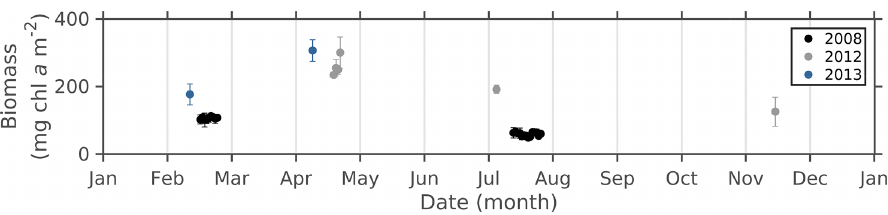
Figure 5. Daily averaged in situ MPB biomass (mgChl a m − 2 ) sampled in the sediment first centimetre at the study station on the Brouage mudflat in 2008 (black full dots), 2012 (grey full dots), and 2013 (blue full dots). Error bars correspond to the standard deviation.